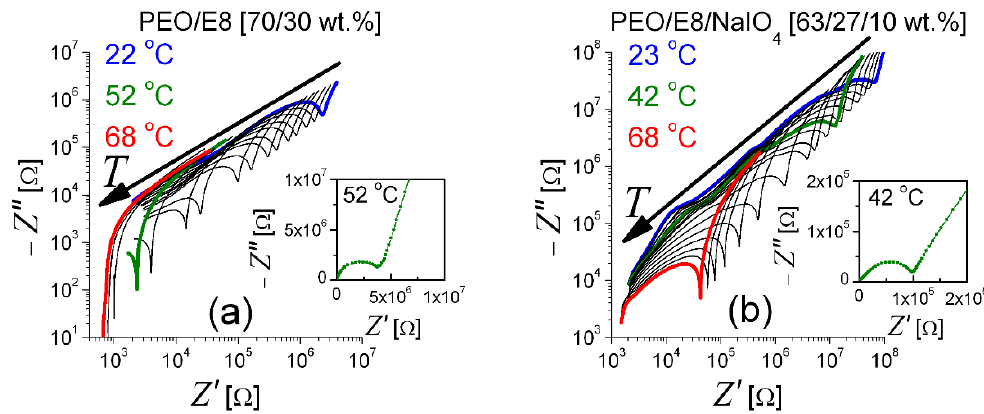
Figure 6. Nyquist plots of PEO/E8 ( a ) and PEO/E8/NaIO 4 ( b ) at various temperatures. The arrows show the effect of increasing temperature. Inserts: the Nyquist plots that correspond to impedances measured at the glass-transition temperature ( T g ) for both composites.